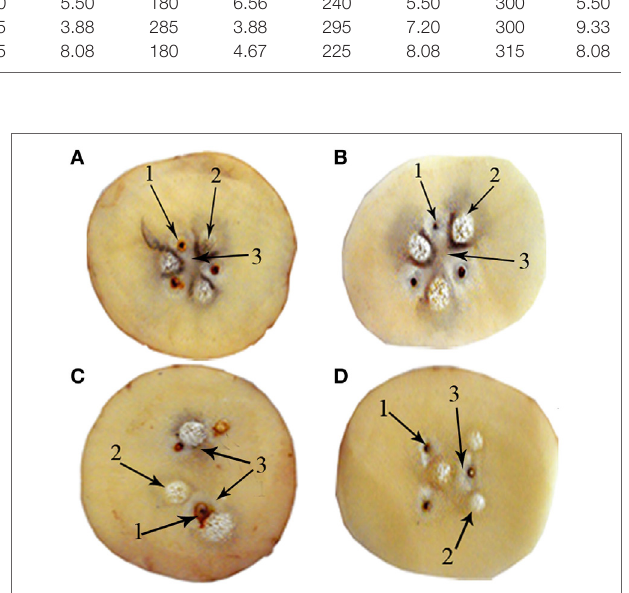
FigUre 2 | Findings of the potato pieces perturbed with 10 mA during 30 min for (a) Configuration I; (B) Configuration II; (c) Configuration III; and (D) Configuration IV. In this figure is shown the necrosis around each electrode (1), bubbling around the cathode (2), and irreversible tissue damage between the electrodes (3).